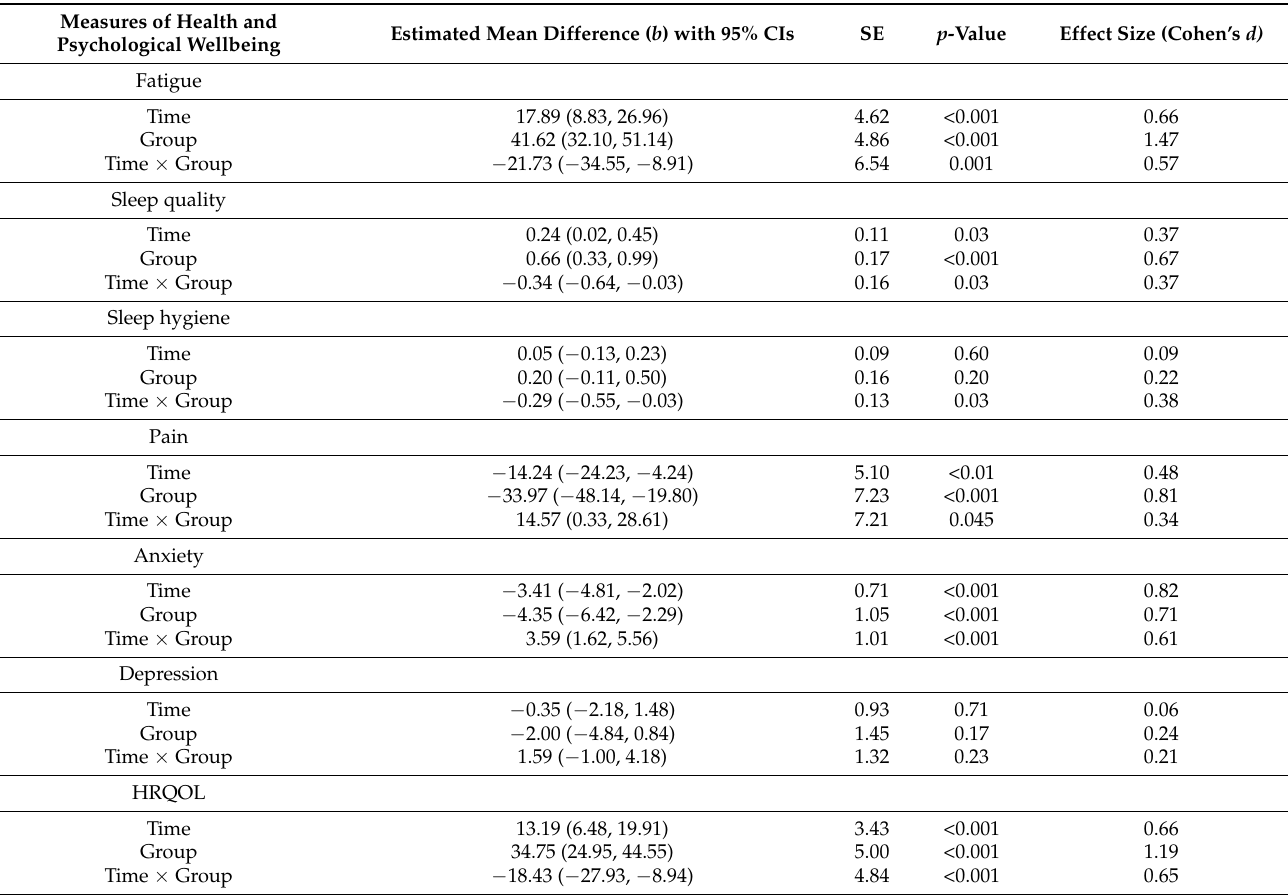
Table 3. Estimated mean differences in health and psychological wellbeing over time (baseline vs. follow-up) and between groups (ME/CFS vs.